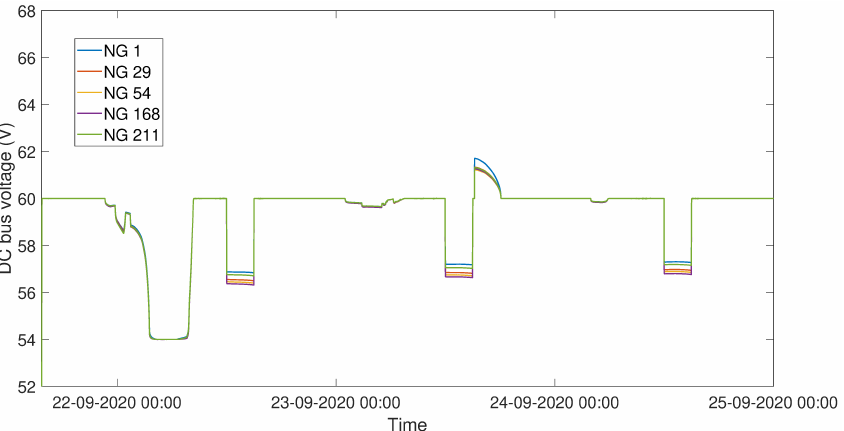
Figure 13. Evolution of the DC bus voltage with a 1500 Wh communal load—communal load